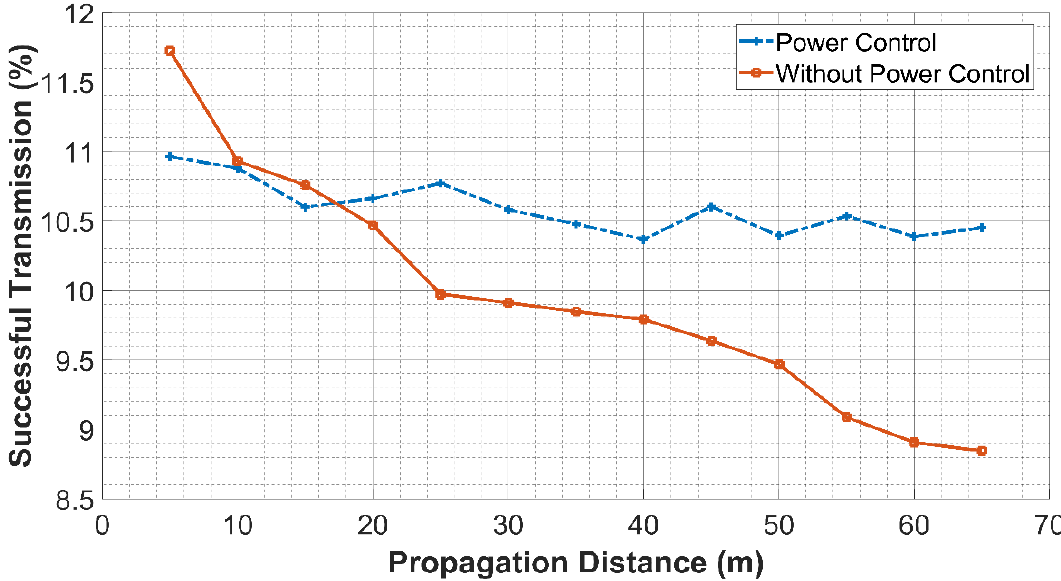
Figure 10. The proportion successful transmissions as a function of distance from the hub at maximum